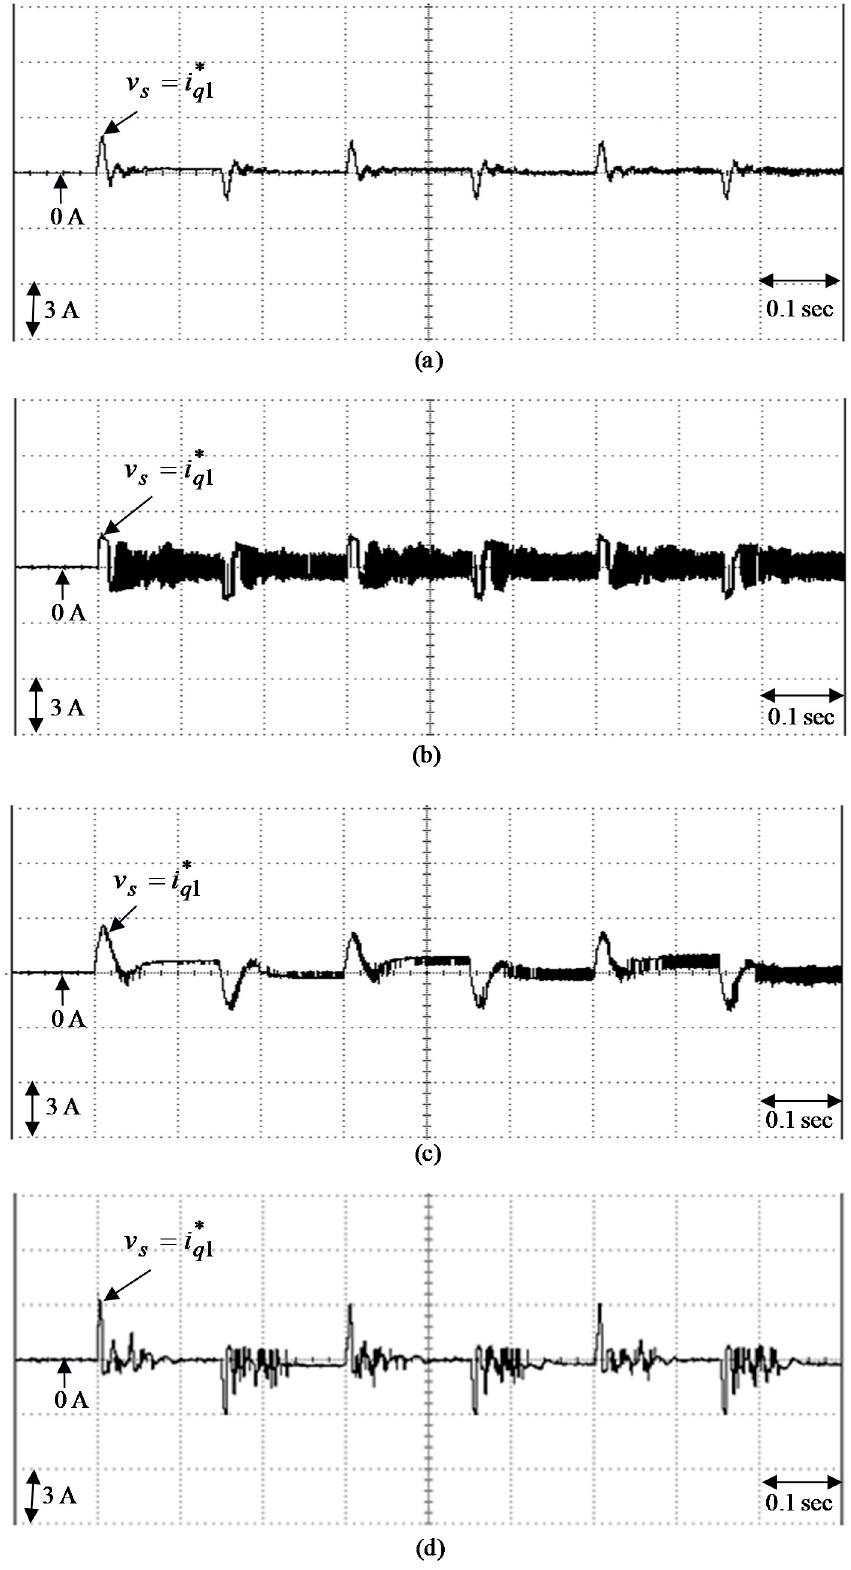
Figure 9. Experimental results of the response of control propulsion in Case R1 ( a ) by utilizing control system W1, ( b ) W2, ( c ) W3, and ( d ) W4.